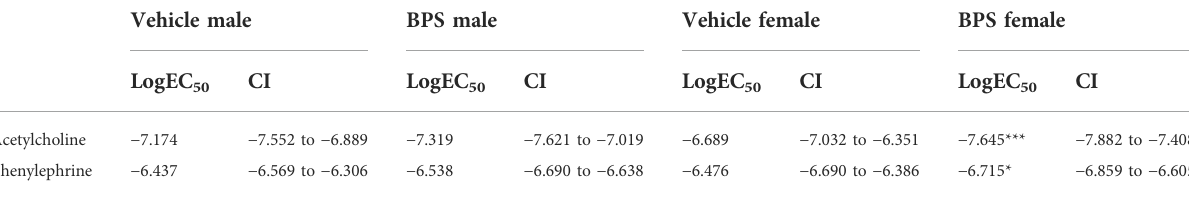
TABLE 1 EC 50 values of mesenteric arteries isolated from BPS-exposed or control mice. Vehicle